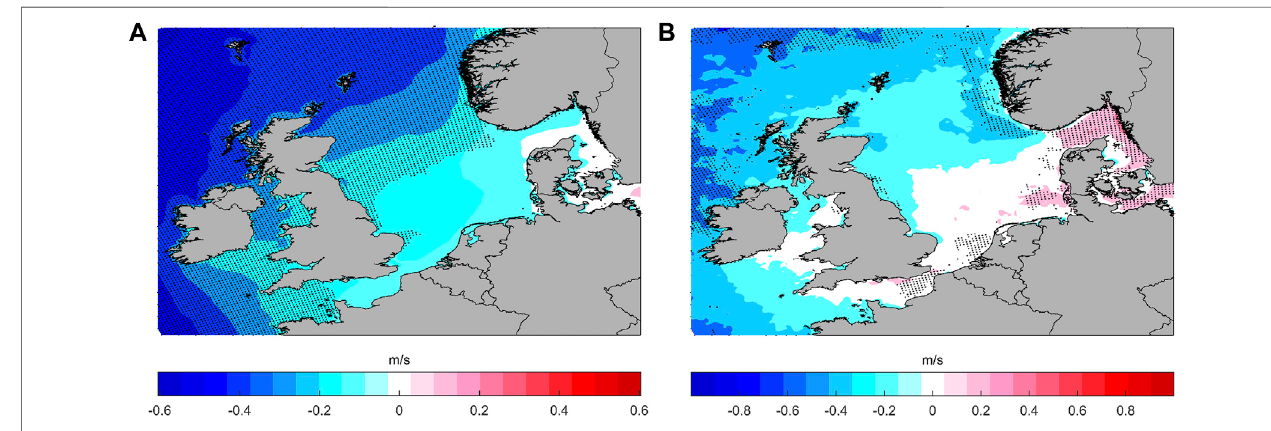
FIGURE 10 | Projected variations in mean wind speed (A) , 99th percentile wind speed (B) for the period 2081-2100 under RCP8.5 scenario. Black dots stand for results